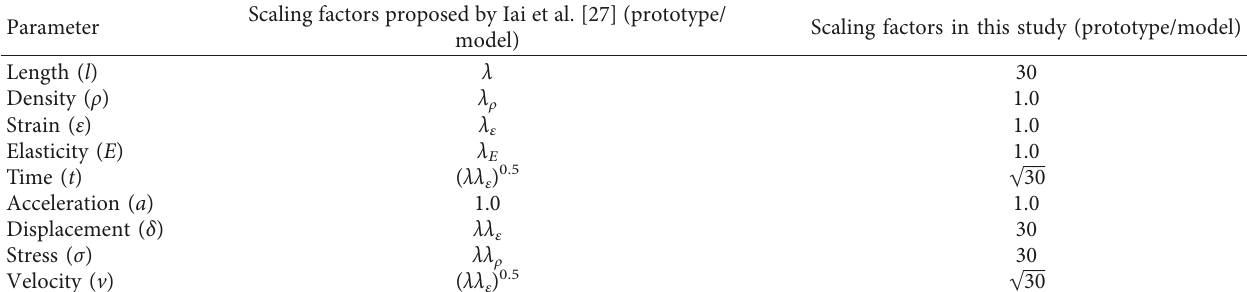
Table 1: Scaling factors for 1g shaking table test.